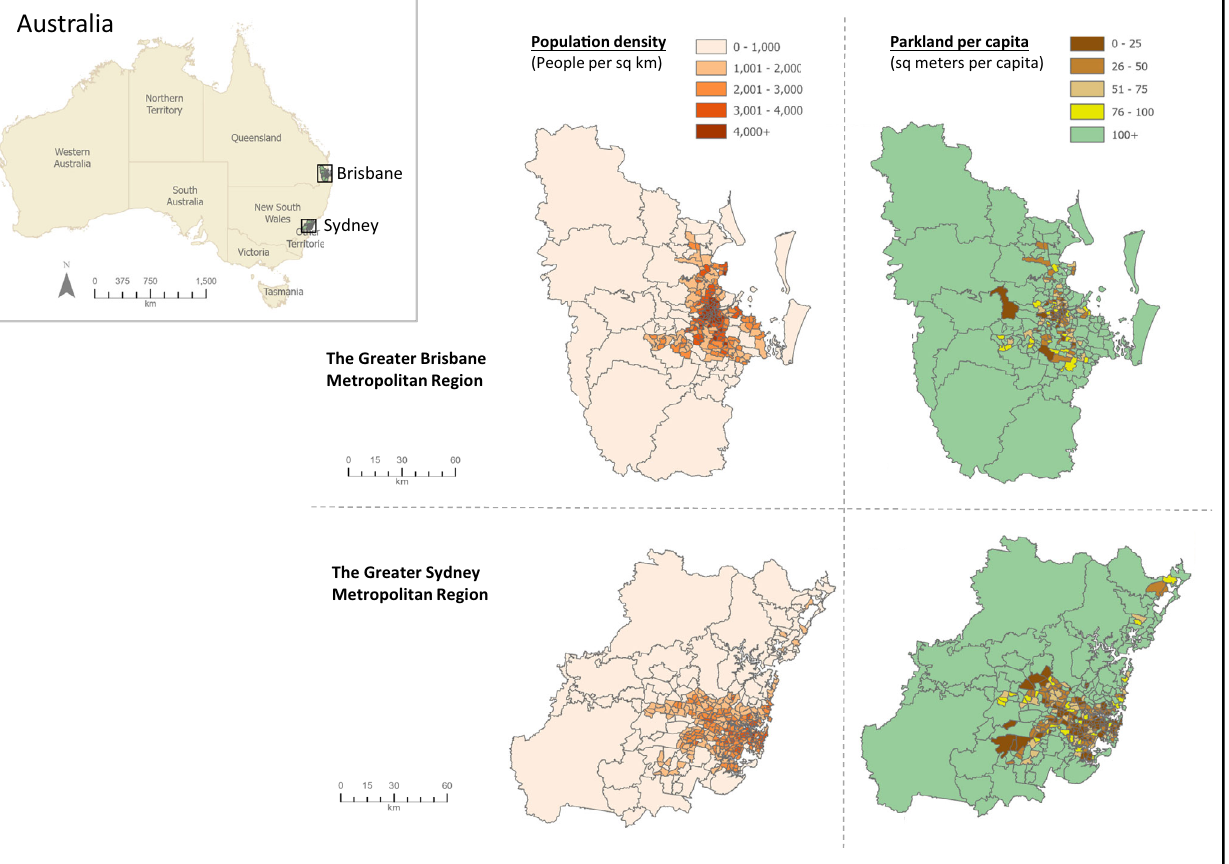
Fig. 1 Maps of the Greater Brisbane Metropolitan Region and Greater Sydney Metropolitan Region — as de fi ned by the Australian Bureau of Statistics. Maps are based on the same scale to show the relative size of each Metropolitan Region (Data by Region, https://dbr.abs.gov.au/). Population density and parkland per capita information is shown at the statistical area 2 level from the Australian Bureau of Statistics and represents a community that interacts together socially and economically. These maps show the relatively equal sizing of the metropolitan areas and the distribution of the population and park availability across the